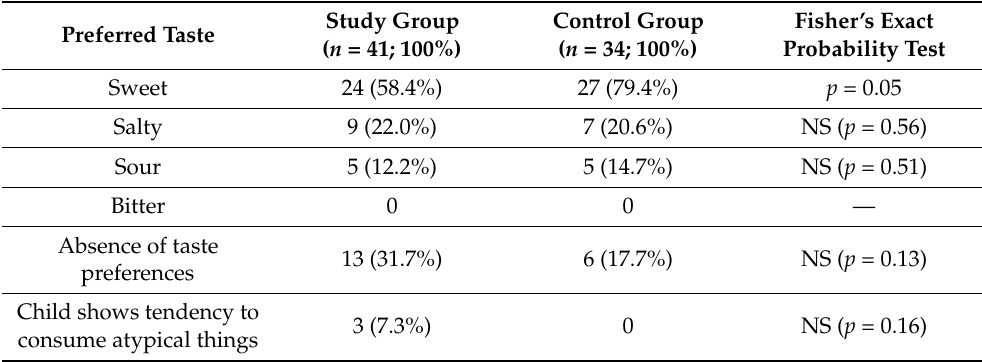
Table 9. Tastes of food preferred by the children in the Study Group and the Control Group (ques- tion